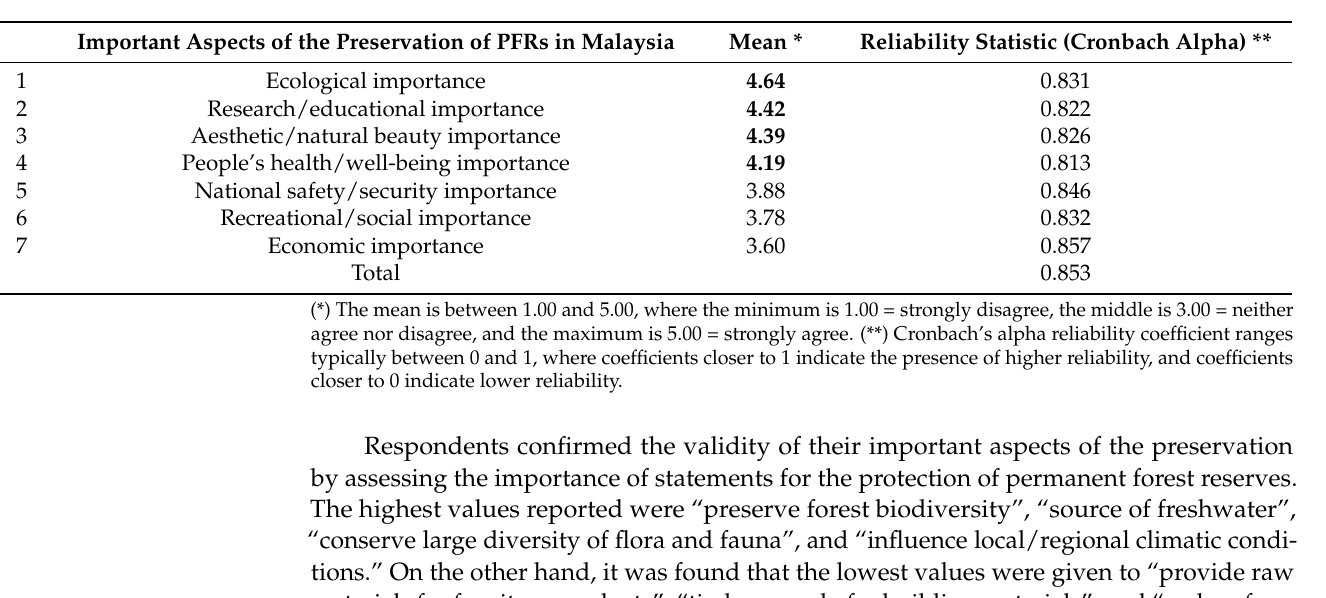
Table 5. The opinions of the respondents on the important aspects of the preservation of PFRs in Malaysia.